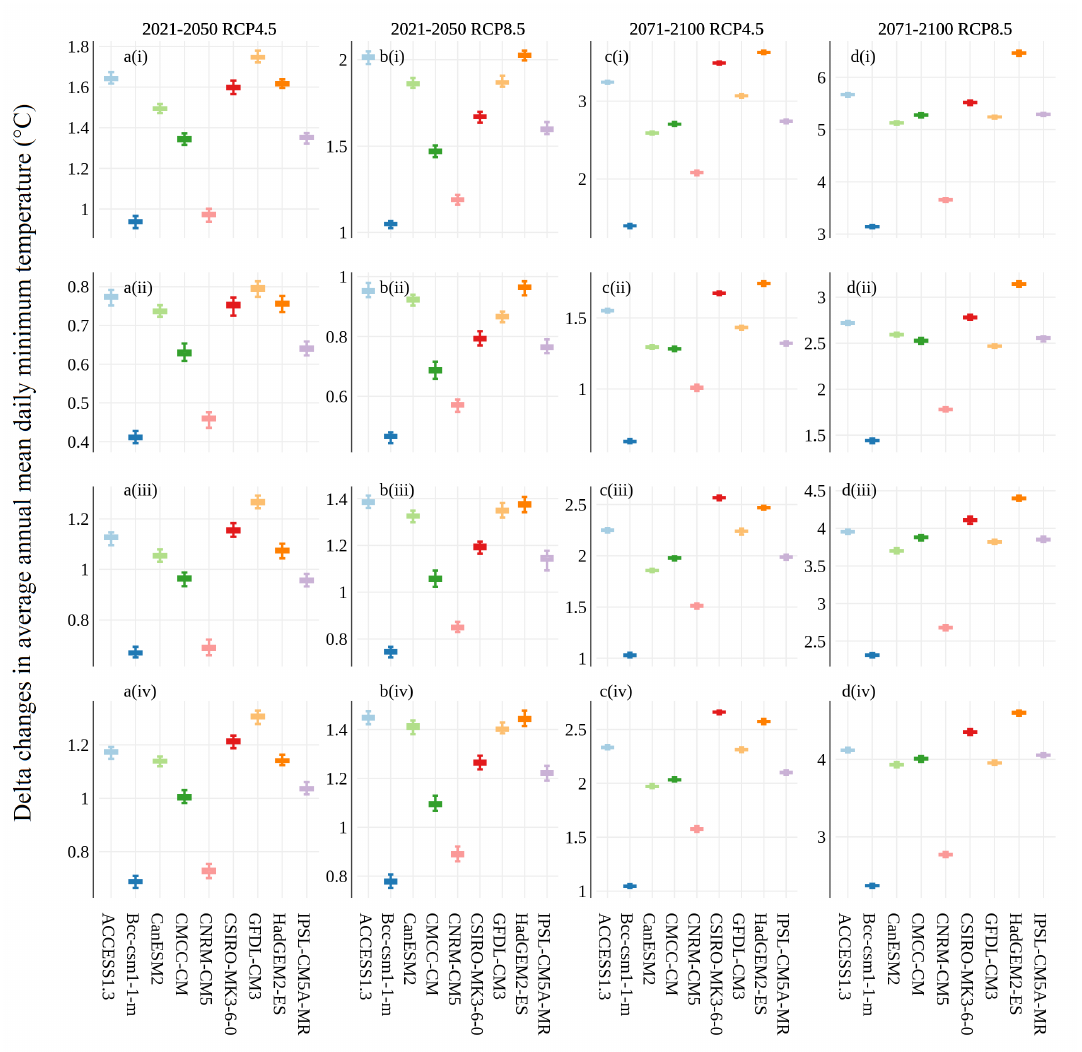
Figure 8. Delta changes in long-term average annual mean daily minimum temperature from downscaled GCM data for: ( a ) 2021–2050 period under RCP4.5 scenario; ( b ) 2021–2050 period under RCP8.5 scenario; ( c ) 2071–2100 period under RCP4.5 scenario; and ( d ) 2071–2100 period under